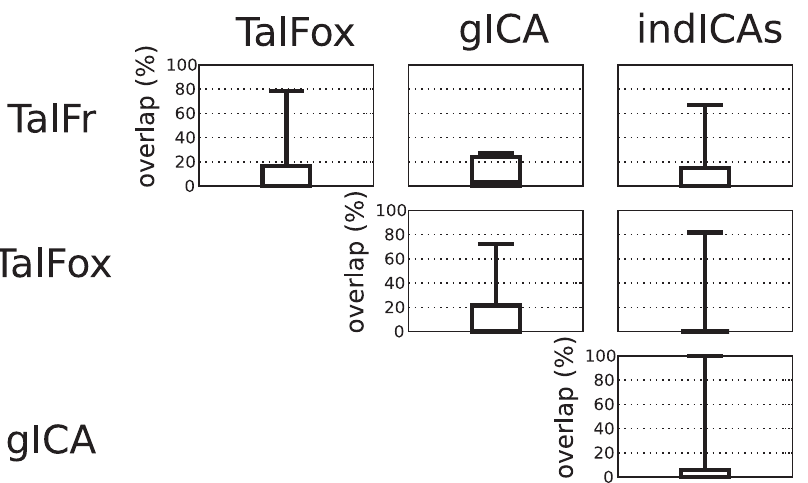
Figure 2. Spatial overlap between ROIs according to the four ROI selection methods. If S 1 and S 2 are the spheres extracted for a given ROI by methods 1 and 2, respectively, then the overlap between methods 1 and 2 for that ROI is computed as volume( S 1 \ S 2 ) = f½ volume( S 1 ) z volume( S 2 ) (cid:2) = 2 g . The bottom and top of the box are the 25th and 75th percentile (the lower and upper quartiles, respectively), and the band in the box is the 50th percentile (median); whiskers represent minimum and maximum values.